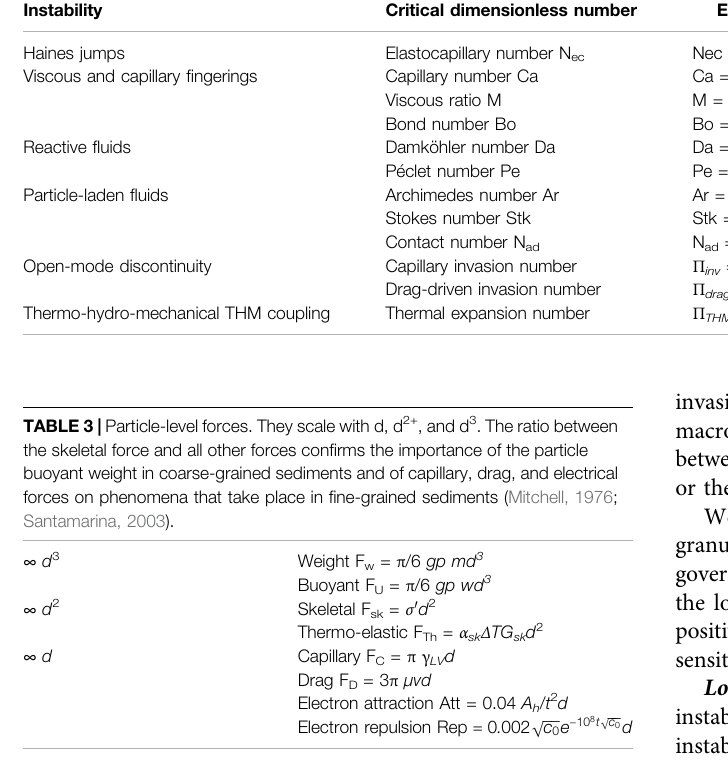
TABLE 2 | Pore/particle scale dimensionless ratios that de fi ne the domains for fl uid-driven instabilities. The selected ratios presented here resemble the analysis in the text. Instability